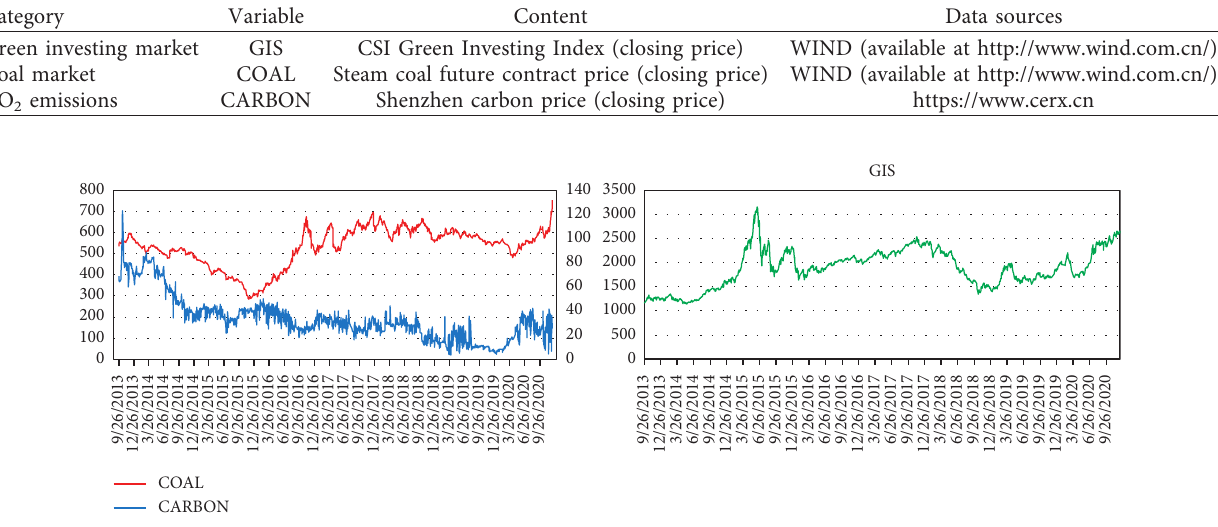
Figure 1: Price trends of the Shenzhen carbon market, coal market, and CSI Green Investing Index.